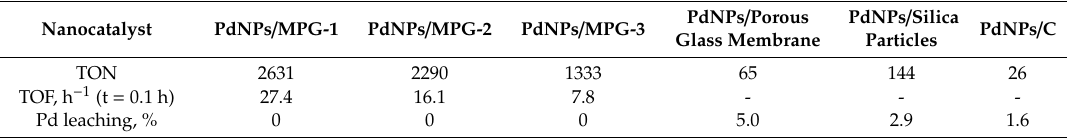
Table 1. Comparison of TONs and TOFs between PdNPs/MPGs, PdNPs/porous glass membrane, PdNPs/silica particles and PdNPs/C and Pd leaching.